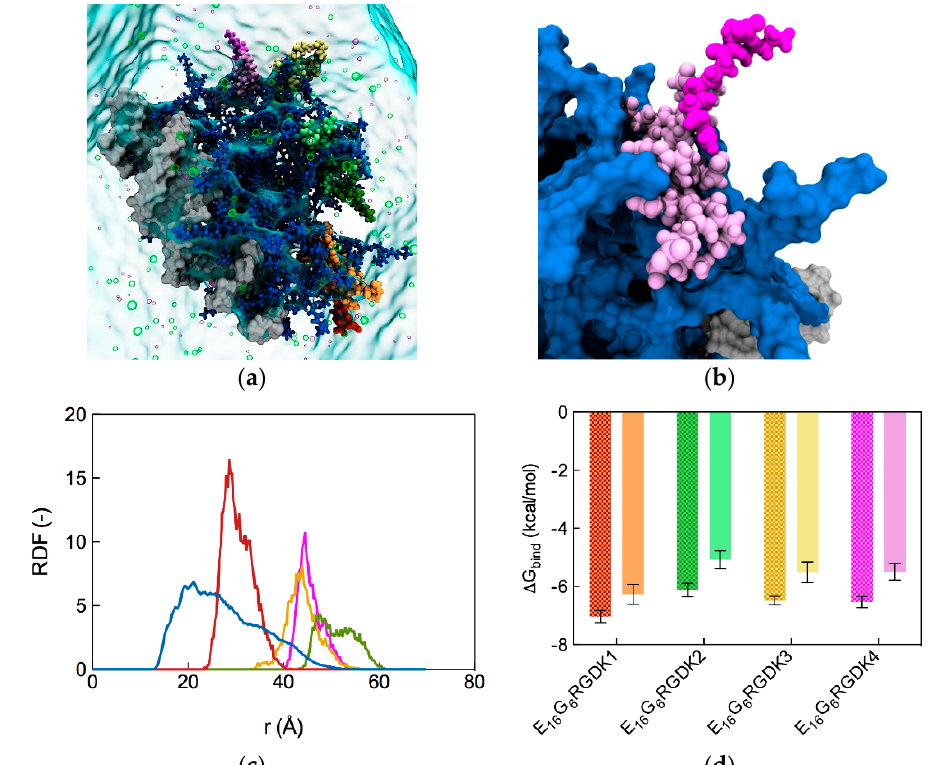
Figure 14. ( a ) Image extracted from the equilibrated portion of the MD simulation of a siRNA/ AD micelle in complex with 4 E 16 G 6 RGDK peptides performed in 150 nM NaCl water solution. The 4 peptides are numbered and colored as follows: E 16 G 6 RGDK1, tail (E 16 G 6 ) sandy brown, head (RDGK) firebrick; E 16 G 6 RGDK2, tail light green, head olive drab; E 16 G 6 RGDK3, tail khaki, head golden rod; E 16 G 6 RGDK4, tail plum, head magenta. The AD micelle is in a dark slate blue sticks-and-balls representation, the siRNA molecule is highlighted by its gray van der Waals surface, the peptides are shown as colored spheres, Na + and Cl − ions are depicted as purple and green hollow spheres, while a light cyan transparent surface is used to represent the water solvent. ( b ) Zoomed view of the image in panel ( a ), showing the E 16 G 6 RGDK4 peptide with its tail (plum) attached to the micelle surface and its RGDK warhead (magenta) protruding into the solvent. In this panel, water and ions are omitted for clarity. ( c ) Radial distribution function (RDF) from the AD center of mass for the positively charged AD terminal groups (dark slate blue), and for each of the four RGDK warhead groups (colors as in panel ( a )). ( d ) Free energy of binding ( Δ G bind ) of each E 16 G 6 RGDK peptide on the siRNA/ AD micelle. The patterned bars represent the Δ G bind values for the entire peptide molecule, while the solid bars show the contribution to Δ G bind afforded by the negatively charged (E 16 G 6 ) tails only. Adapted from [8] with permission of the American Chemical Society, 2018.